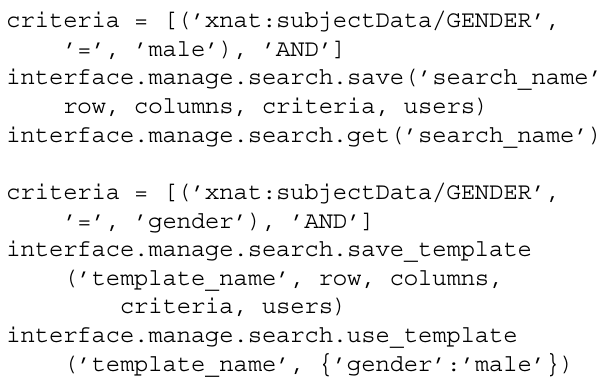
FIGURE 8 | PyXNAT and NiPyPE